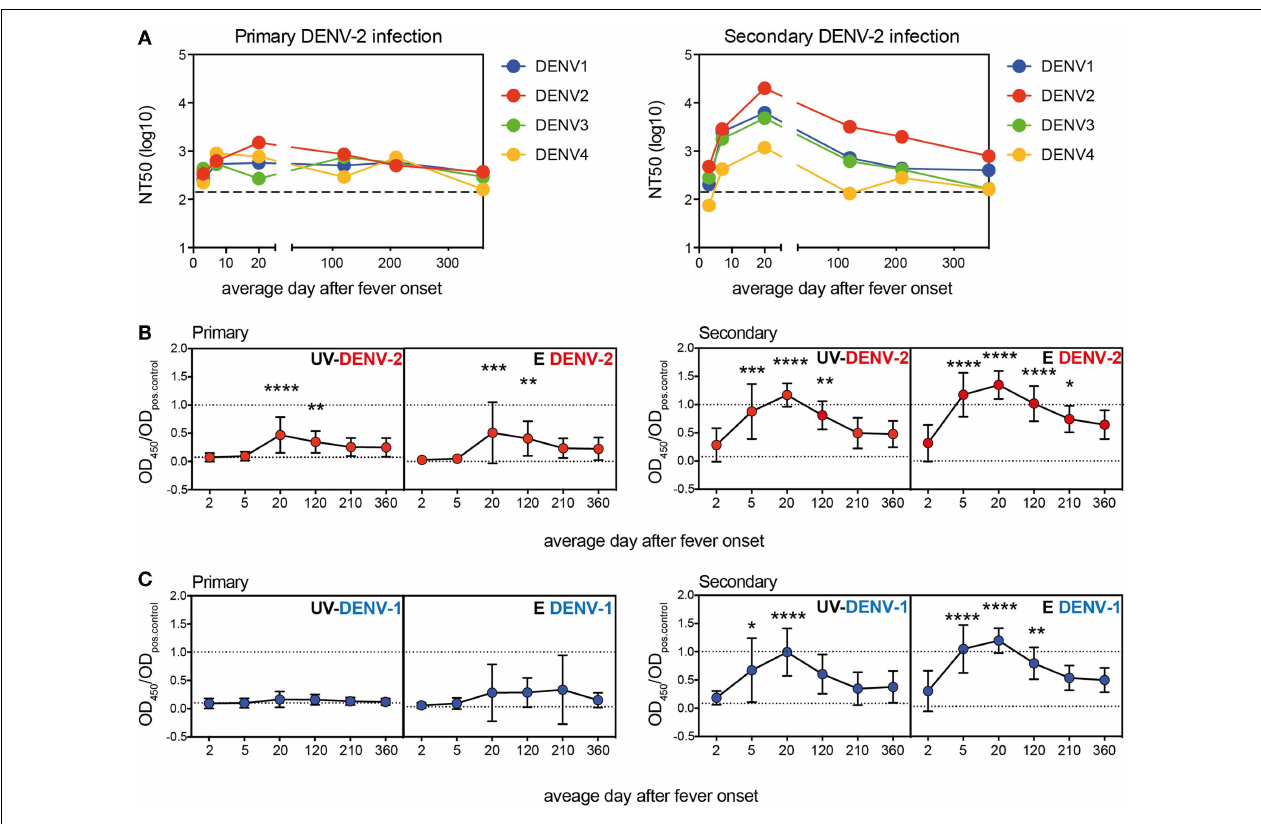
per group. (B,C) ELISA to test binding of plasma antibodies to UV-treated, PEG-enriched DENV, or to recombinant E protein of DENV-2 (B) and DENV-1 (C) . A one-way ANOVA test was performed. * p < 0.05, ** p < 0.01, *** p < 0.001, **** p < 0.0001 indicate titers that were significantly different from the titers measured within 72h of fever onset (average day 2). Dashed lines indicate values for the positive and negative control,